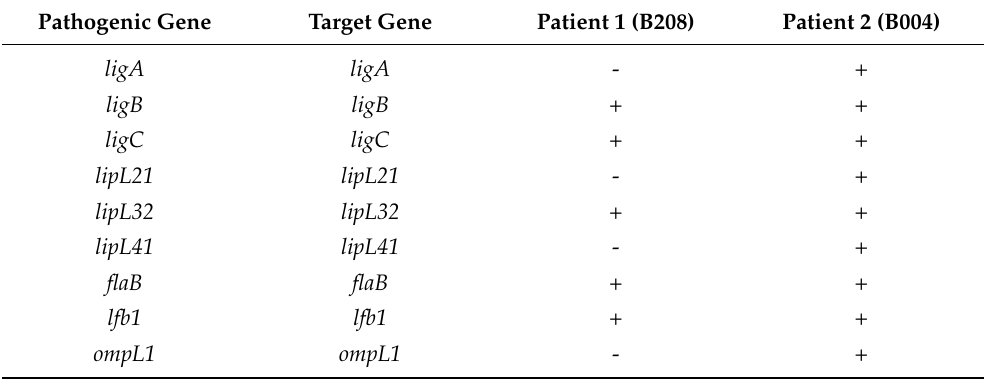
Table 3. Detection of pathogenic genes of the isolates from positive cultures, based on PCR amplification.